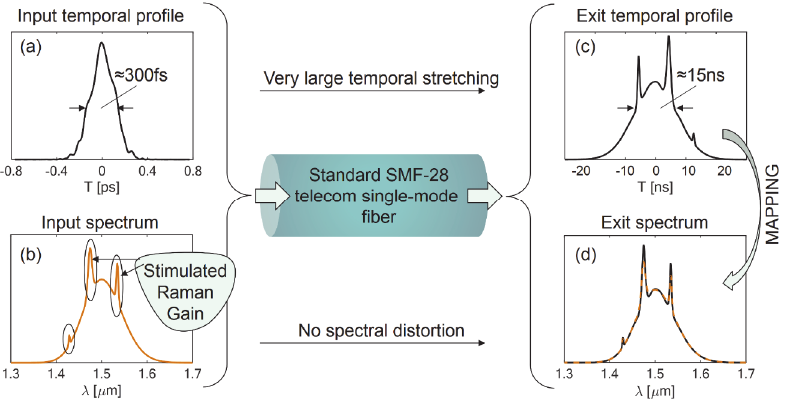
Fig. 1. Working principle of photonic time